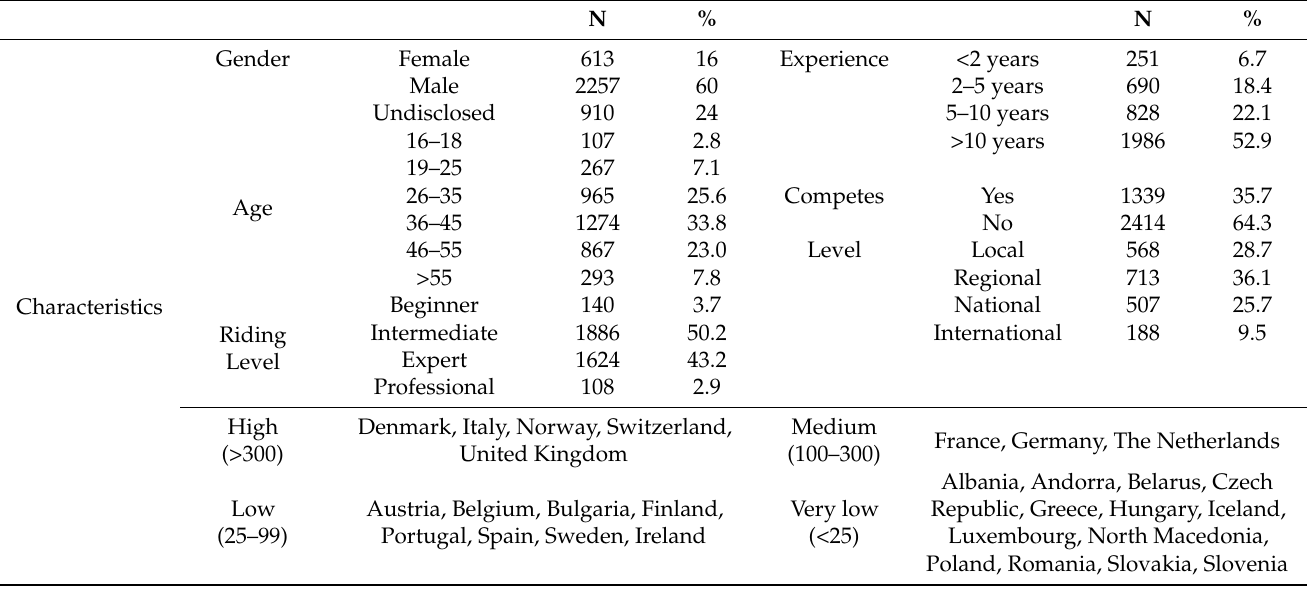
Table 2. Respondent characteristics and response rates by country (n = 3780). N % N %